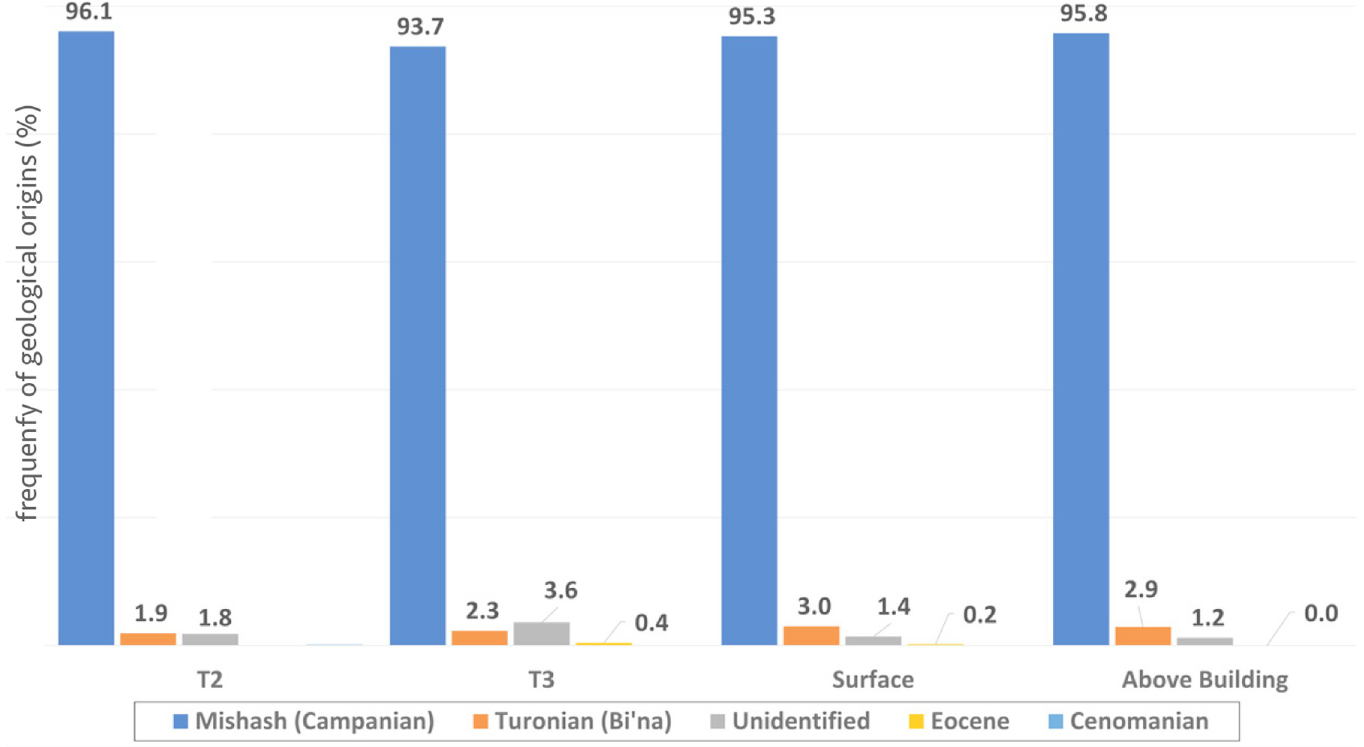
Fig 21. Frequencies of the geologic flint raw material by assemblage.